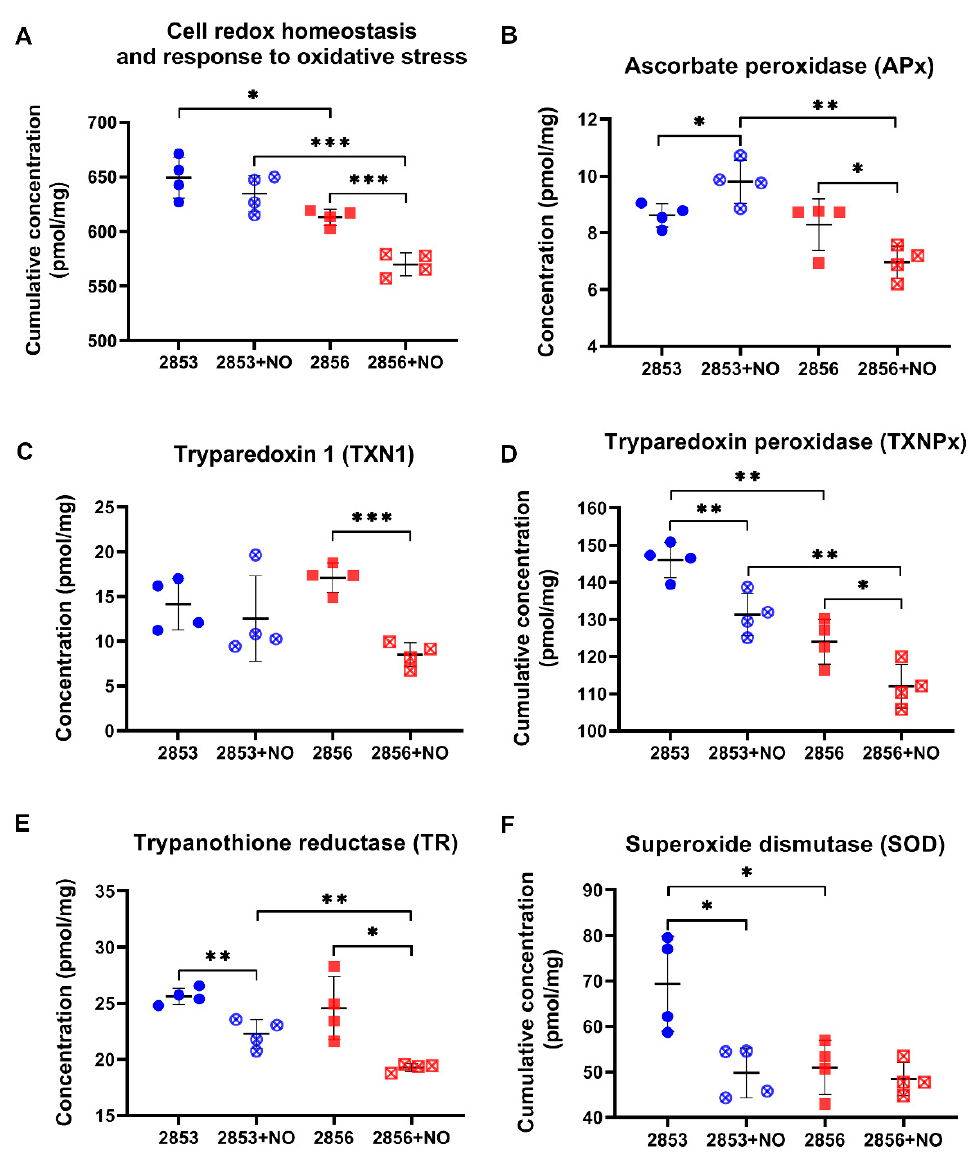
Figure 4. The antioxidant proteins of NO-susceptible L. braziliensis strain are negatively modulated after the nitrosative challenge. ( A ) Cumulative concentration of all identified proteins involved in biological processes of “ cell redox homeostasis and response to oxidative stress ”. Each symbol shows the total sum of the concentration values of proteins involved in those processes in each of the four biological replicates. Concentrations of specific proteins involved in response to oxidative stress: ( B ) ascorbate peroxidase (APx); ( C ) tryparedoxin 1 (TXN1); ( D ) tryparedoxin peroxidase (TXNPx); ( E ) trypanothione reductase (TR); and ( F ) superoxide dismutase (SOD). Graphs represent mean ± SD of four independent experiments. Statistical differences by Student’s t test (* p < 0.05; ** p < 0.01; *** p < 0.001). 2853: NO-resistant strain; 2853+NO: NO-resistant strain challenged with 1 / 5 IC 50 /4h NaNO 2 ; 2856: NO-susceptible strain; and 2856+NO: NO-susceptible strain challenged with 1 / 5 IC 50 /4h NaNO 2 .